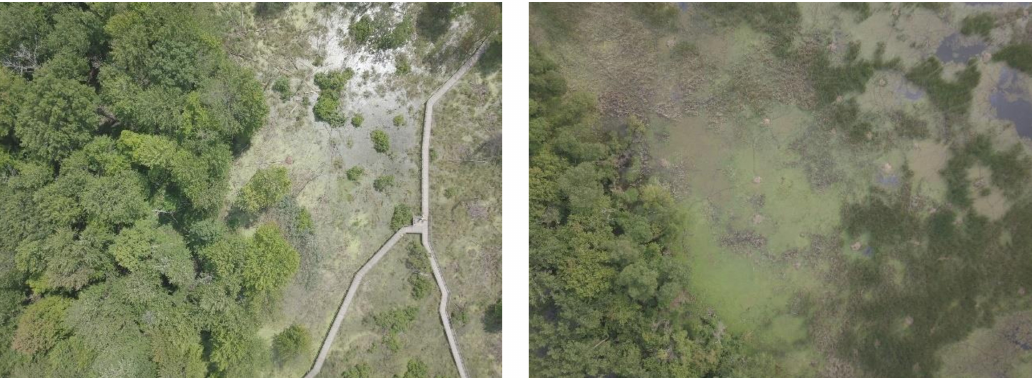
Figure 3. Examples of unprocessed natural color UAV images collected for this project, both taken with the DJI Mavic Pro (Left: Site 124. Right: Site 82.).